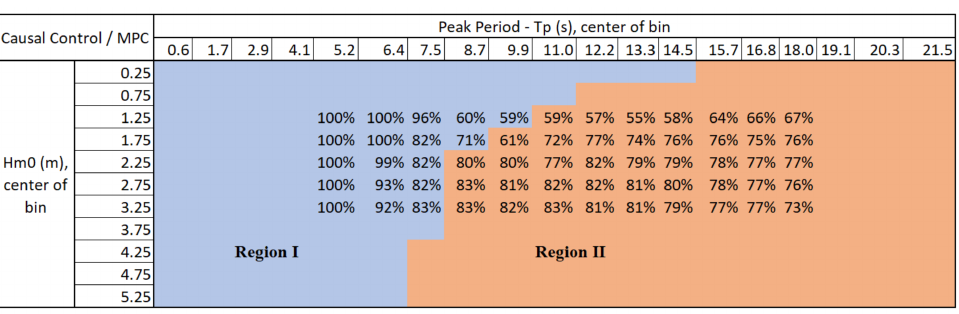
Figure 10. Avg. power (causal control)/avg. power (MPC) for a set of power-producing sea states.